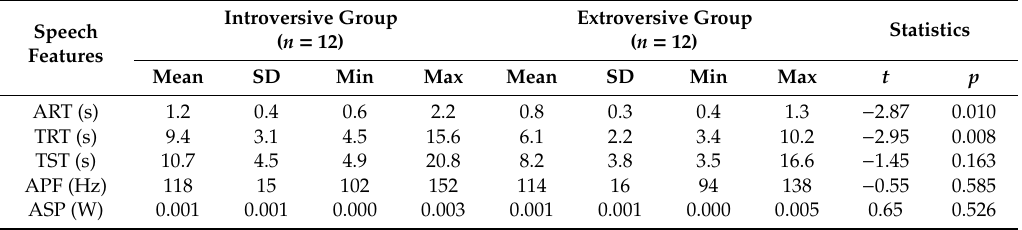
Table 2. Descriptive statistics of the speech and sound features of the introversive and extroversive